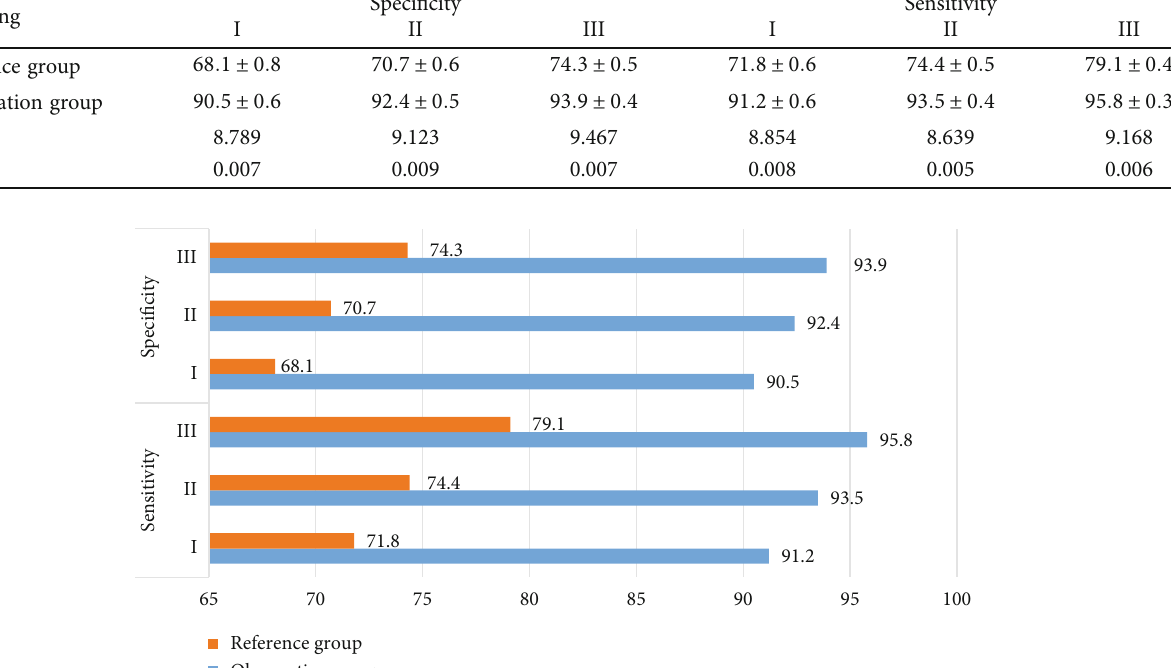
Table 1: Comparison of di ff erent nursing methods for neonatal patients (data source: self-statistics of the study). Grouping